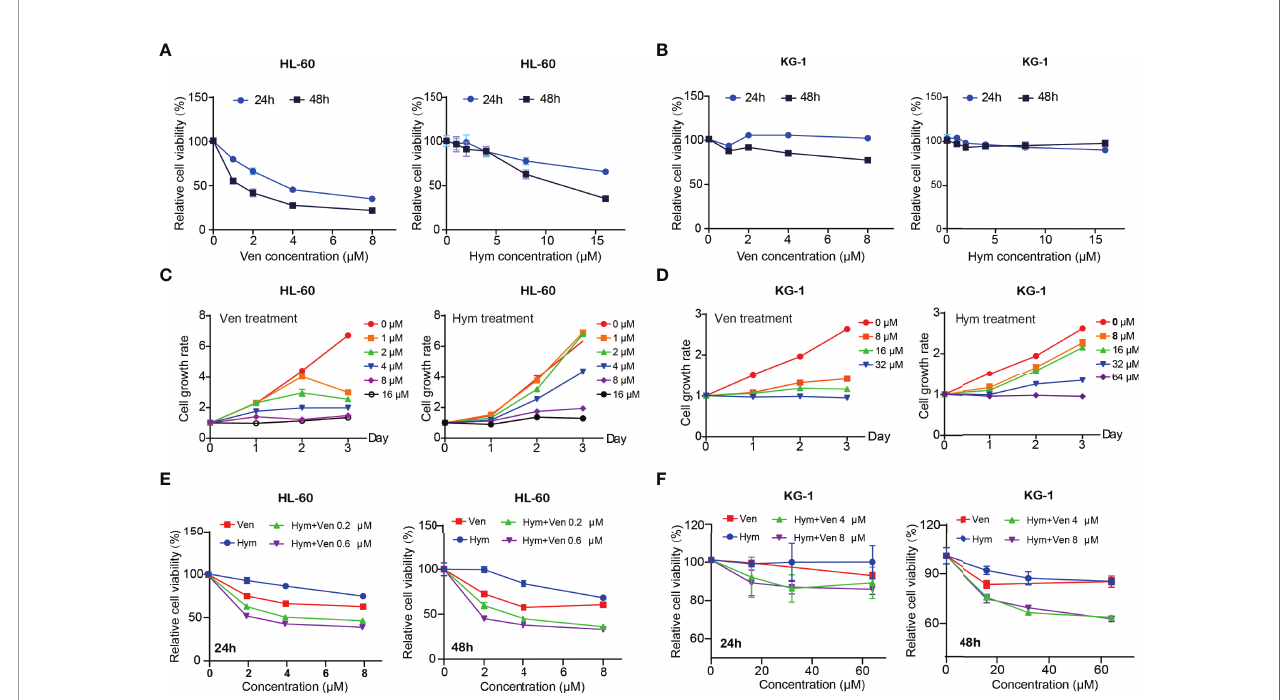
FIGURE 3 | Venetoclax and hymeglusin inhibit the cell viability in acute myeloid leukemia (AML) cells. (A, B) The relative cell viability curve after gradient concentration of venetoclax (0 – 8 m M) and hymeglusin (0-16 m M) treatment for 24 to 48 hours in HL-60 (A) and KG-1 cells (B) . (C) Cell growth rates after venetoclax (0 – 16 m M) and hymeglusin (0 – 16 m M) treatment for 24 – 72 h in HL-60 cells. (D) Cell growth rates after venetoclax (0-32 m M) and hymeglusin (0 – 64 m M) treatment for 24 to 72 hours in KG-1 cells. (E) The relative cell viability alterations after venetoclax (0.2 m M) and hymeglusin (0.6 m M) treatment for 24 to 48 hours in HL-60 cells. (F) The relative cell viability alterations after venetoclax (4 m M) and hymeglusin (8 m M) treatment for 24 to 48 hours in KG-1